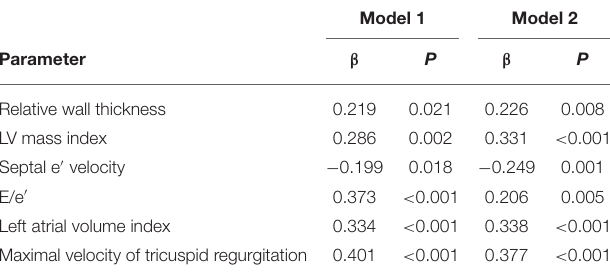
FIGURE 1 | Correlation plots showing the associations of baPWV with indices of LV geometry and diastolic function. Each dot indicates an individual patient’s data. Linear regression line (red line) and 95% confidence interval (shaded area) are depicted. baPWV, brachial-ankle pulse wave velocity; LV, left ventricular; TR, tricuspid regurgitation. TABLE 4 | Multiple linear regression analysis showing the associations of baPWV with parameters of LV geometry and diastolic